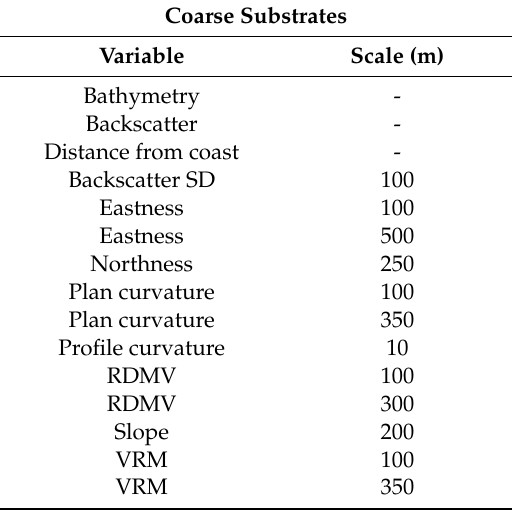
Table 3. Variables selected for coarse substrate